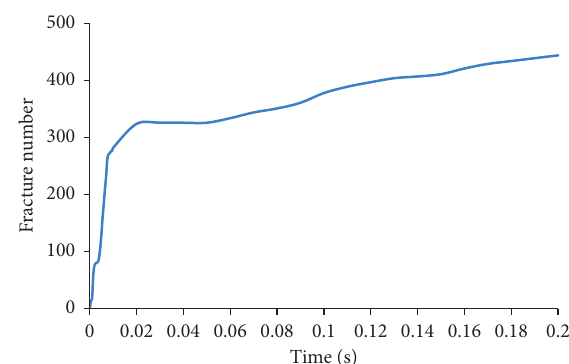
Figure 13: The evolution of fracture number in the surrounding rock under the blasting